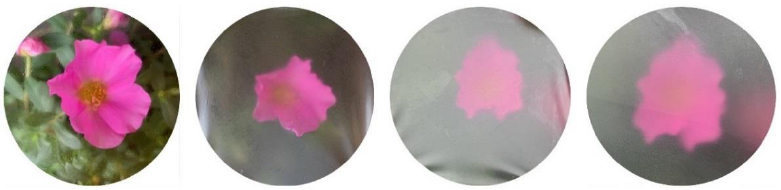
Figure 1. Macroscopic photographs of the films (90% RH) including, from left to right, CMC, CMC + 1% CFEO, CMC + 2% CFEO, and CMC + 3% CFEO.